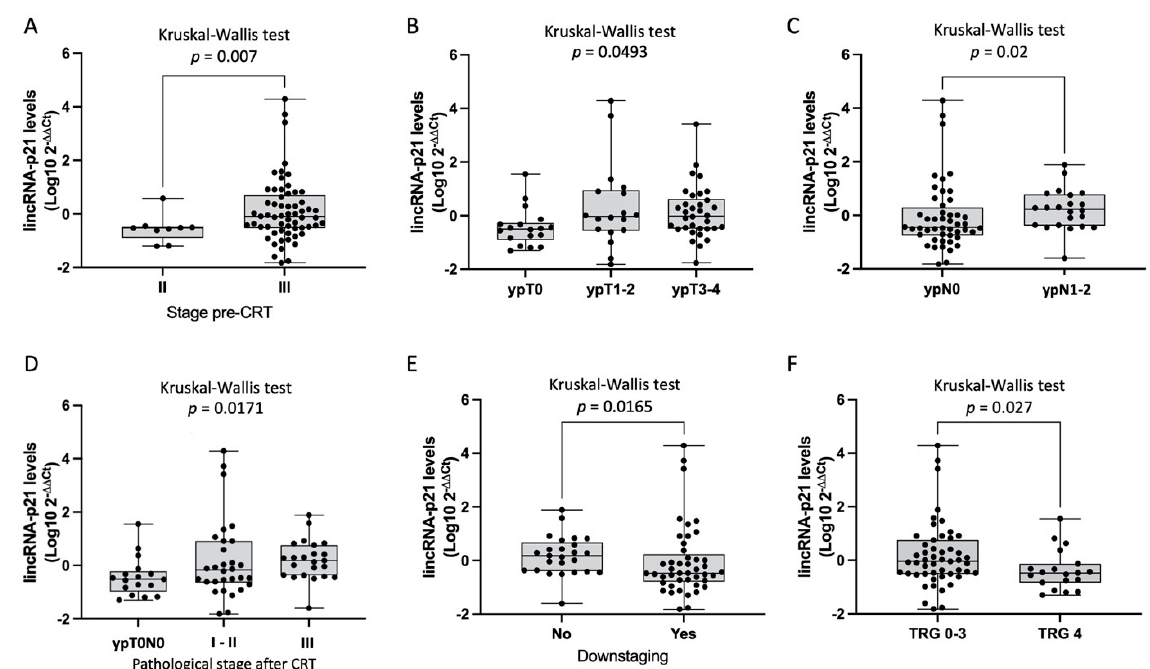
Figure 1. LincRNA-p21 levels and clinicopathological characteristics. ( A ) LincRNA-p21 expression in ( A ) stage III vs. stage II; ( B ) ypT0 vs. ypT-1–2 vs. ypT3–4; ( C ) ypN0 vs. ypN1–2; ( D ) ypT0N0 vs. I-II vs. III; ( E ) downstaging no vs. yes; ( F ) TRG 0–3 vs. TRG 4.